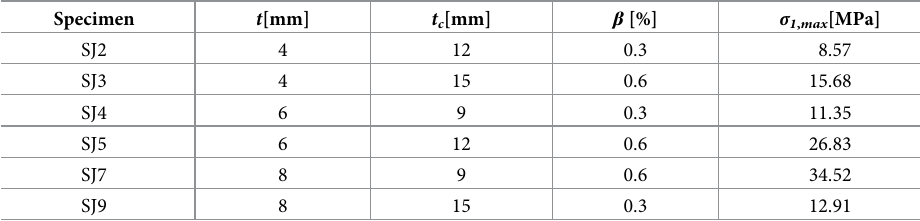
Table 2. Maximum cold-bent stress of each